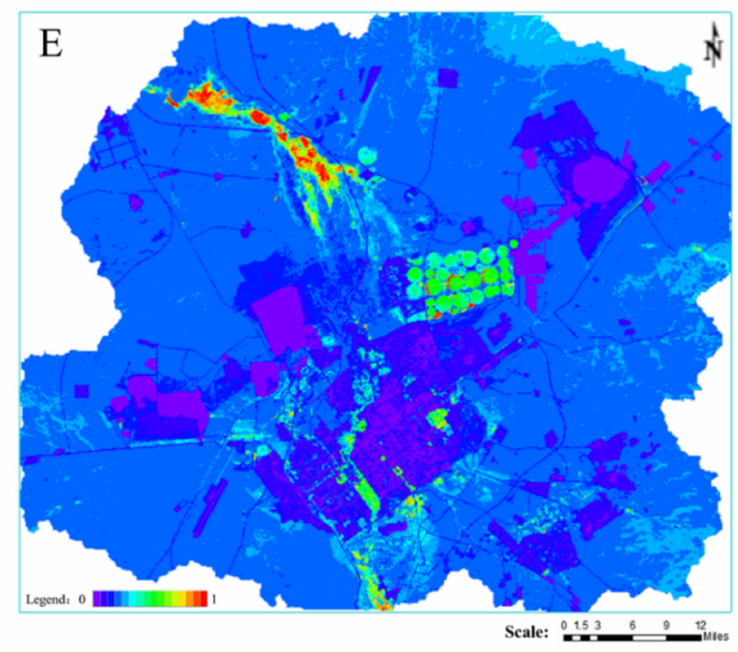
Figure 9. Spatial distribution of ecosystem